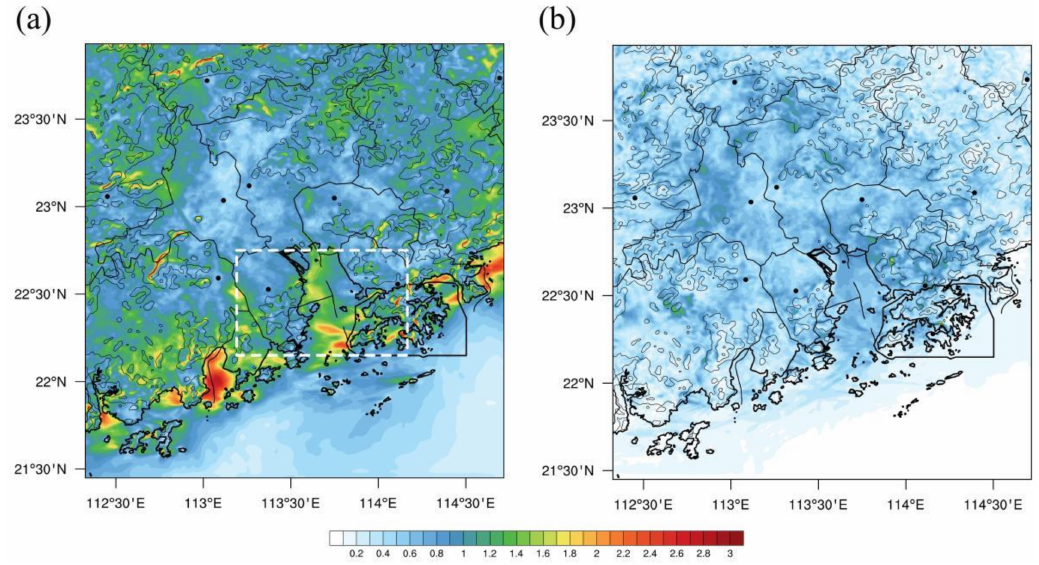
Figure 8. Twenty-four-hour mean RMSD of 10 m wind speed for NoTer ( a ) and NoUrb ( b ) compared to CTRL (from 0000 LST 27 December to 0000 LST 28 December 2020). The white dotted box